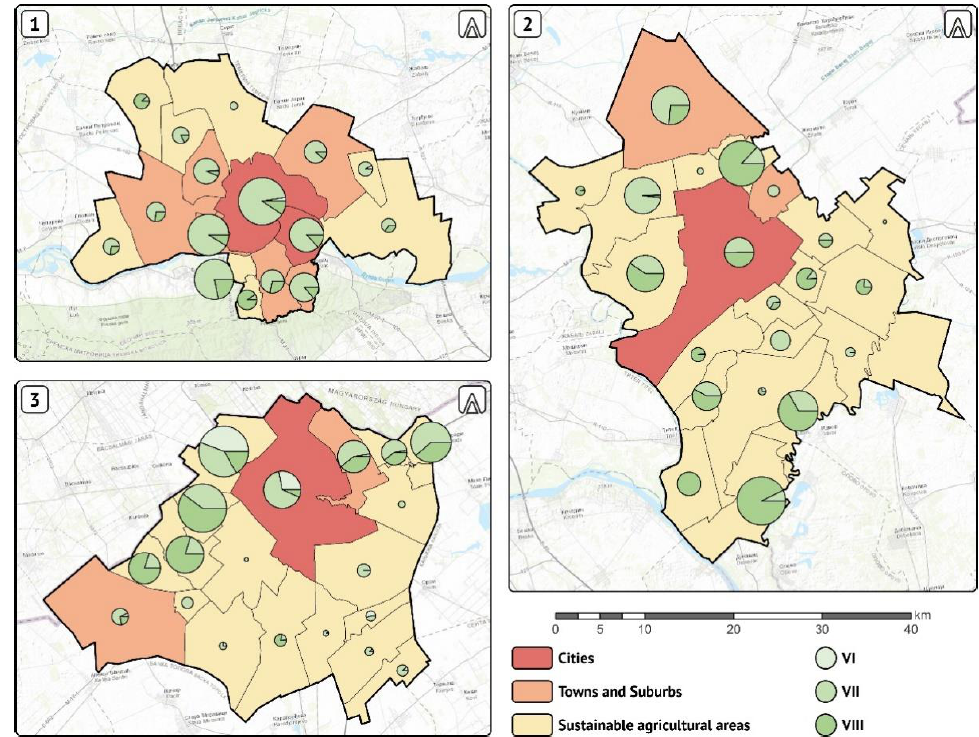
Figure 6. Green infrastructure dots at the local level of settlement character for the ( 1 ) Municipality of Novi Sad, ( 2 ) Municipality of Zrenjanin, and ( 3 ) Municipality of Subotica.